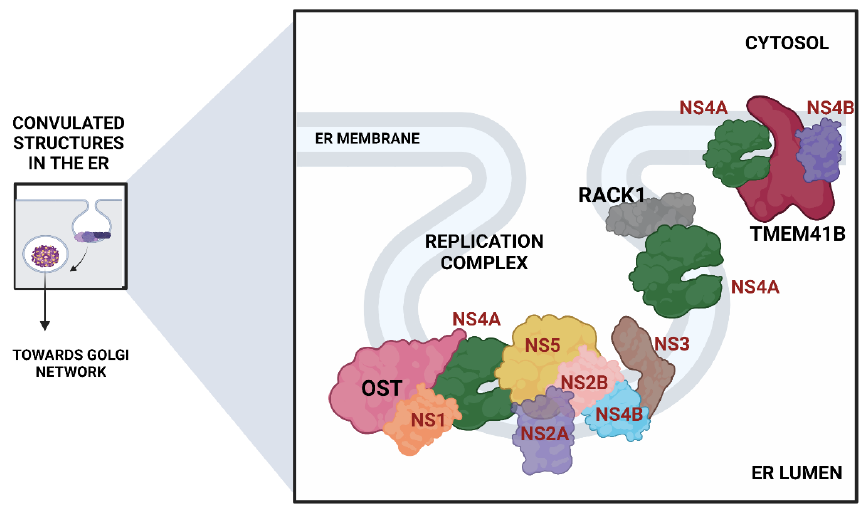
Figure 4. ER remodeling proteins associated with the formation of the viral replication complex. (Viral proteins are shown in red).